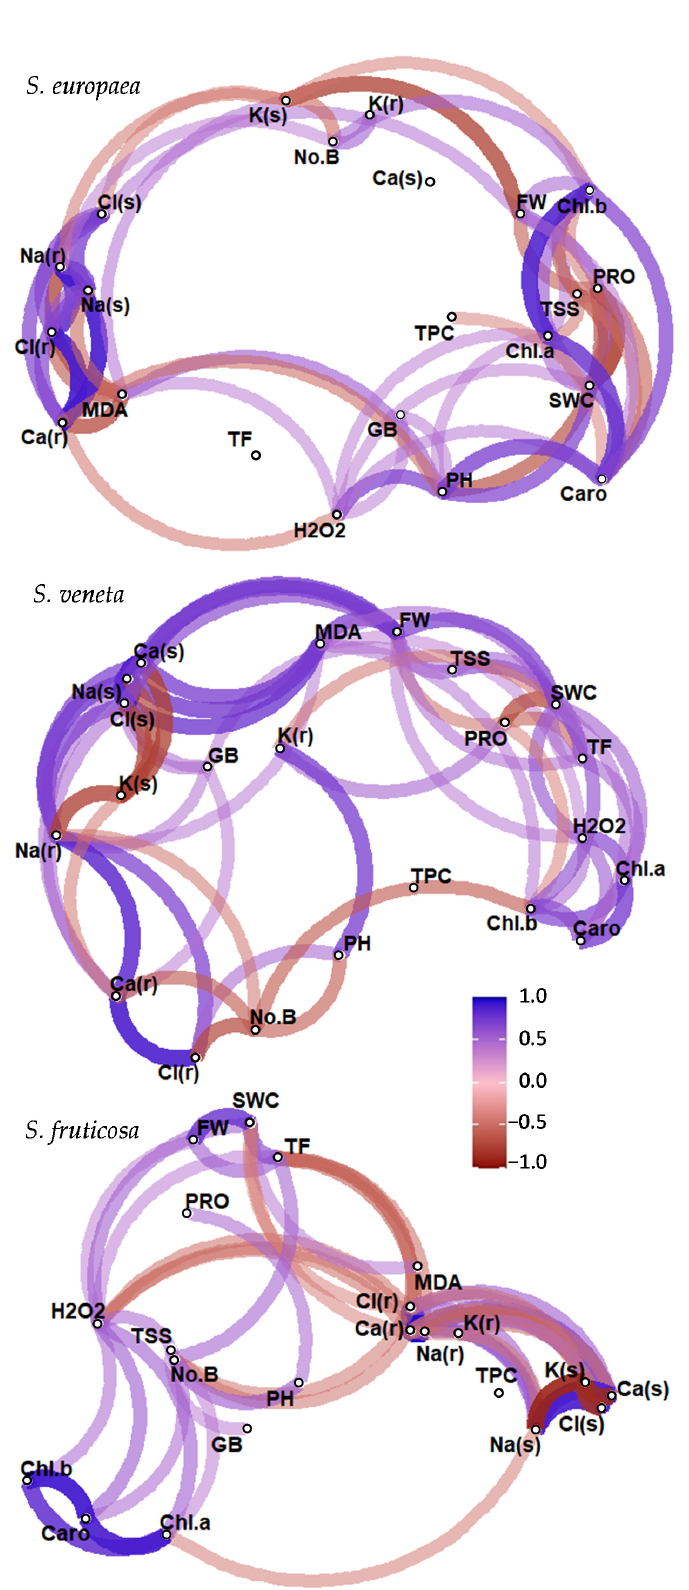
Figure 8. Correlation network diagram showing significant correlations ( p < 0.05) between the 22 measured traits within each halophyte species, based on the calculation of the Pearson correlation coefficients. Each measured trait represents a node, and highly correlated traits are clustered together. Each path represents a correlation between the two variables it joins. A blue path represents a